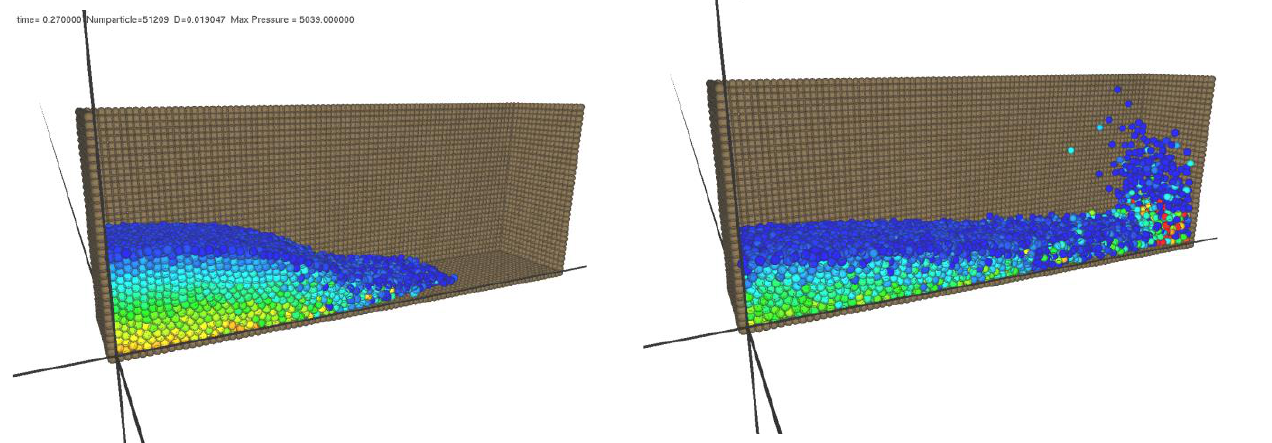
Fig. 13(e). Bird's eye view of dam break simulation (t = 0.62 sec.) .